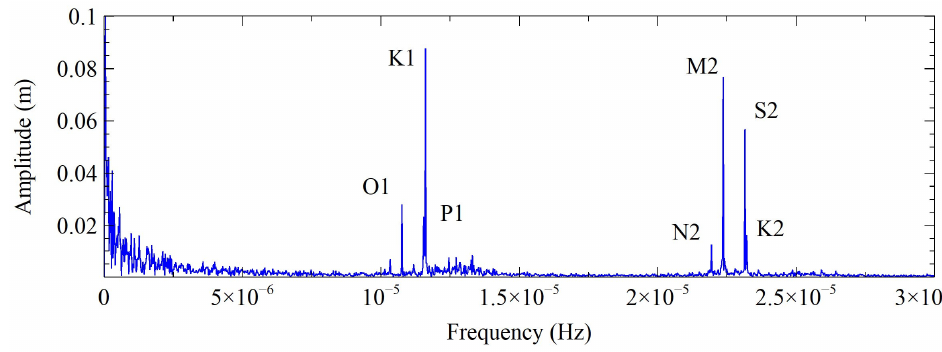
Figure 9. Amplitude Spectral Density for observed sea level reduced for the mean value.